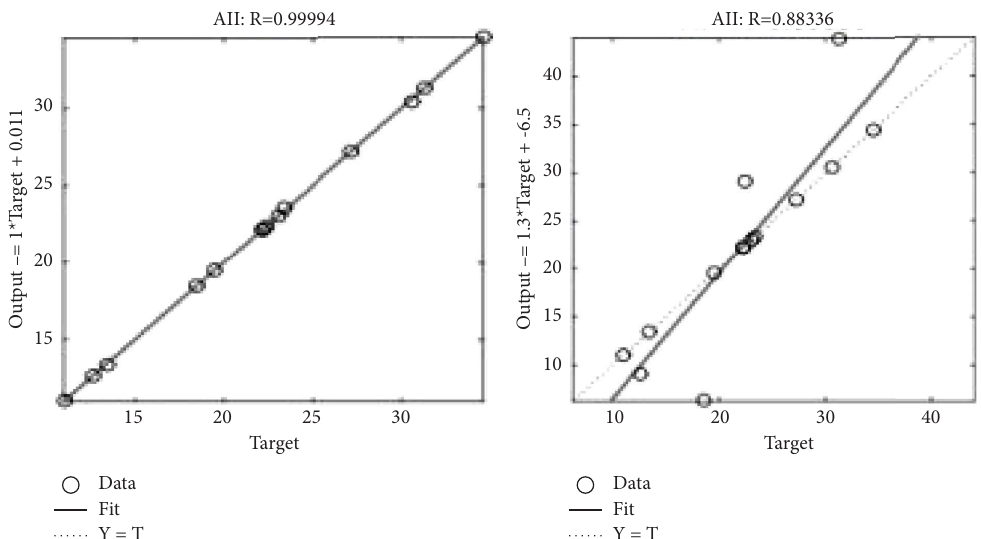
Figure 10: Coefcient of determination for training and cross-validation of